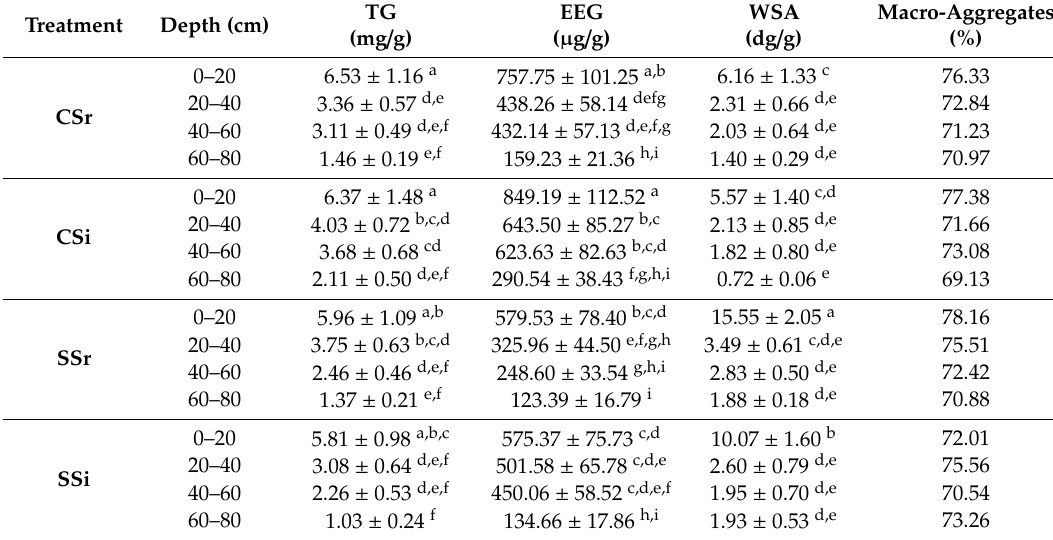
CSr: conventional system in the row; CSi: conventional system inter-rows; SSr: sustainable system in the row; SSr: sustainable system inter-rows. Di ff erent lowercase letters indicate a statistical di ff erence at p < 0.05.